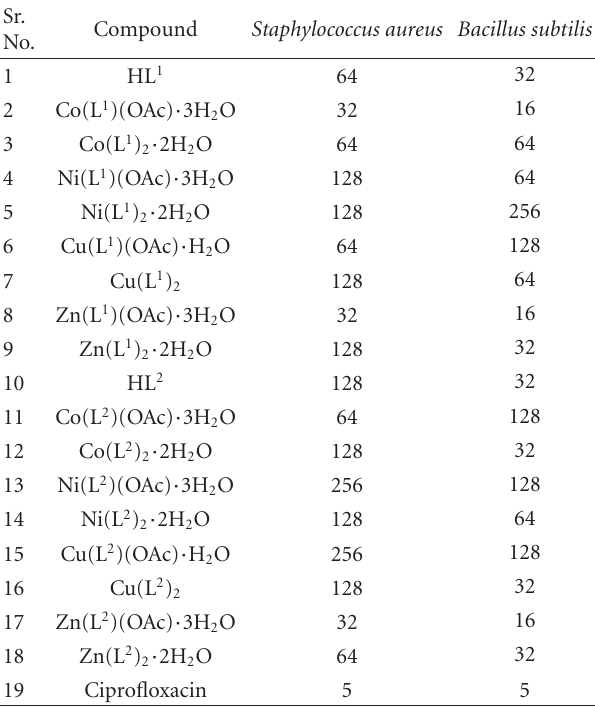
Table 6: Minimum inhibitory concentration (MIC) (in μ g/mL) of compounds.